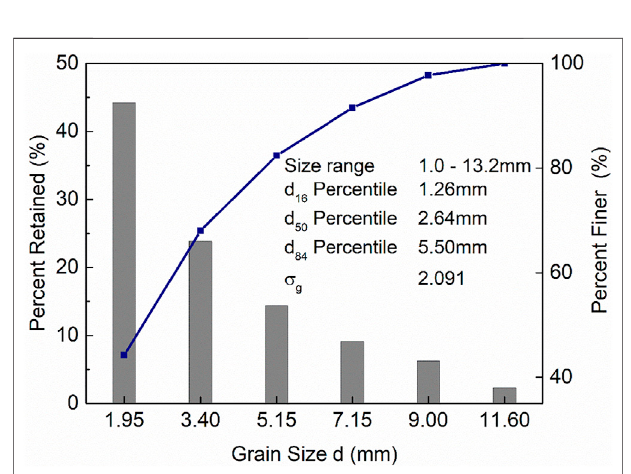
FIGURE 3 | Grain size distribution and percentiles for graded sediment mixture tested in the current study (Wang et al., 2021).